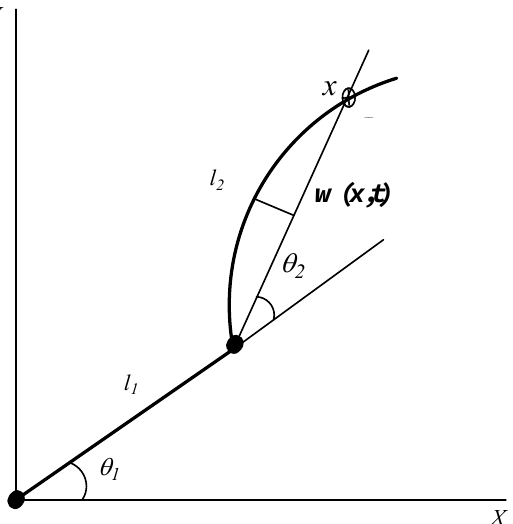
Fig. 1. Schematic diagram of rigid-flexible manipulator and its